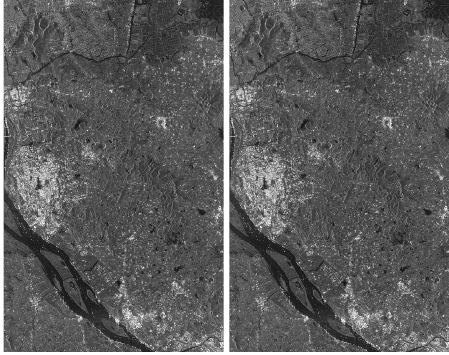
Figure 4 SLC images from this experiment